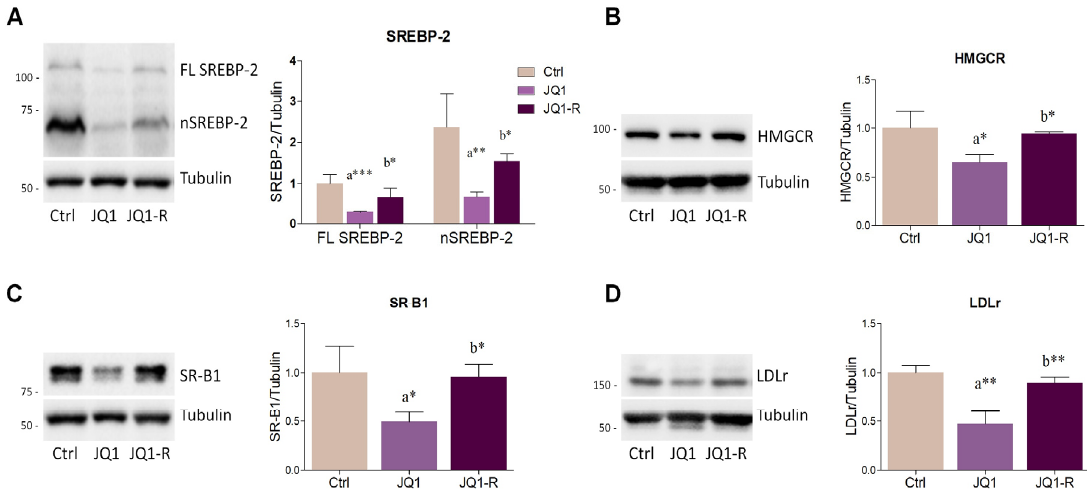
Figure 7. JQ1 resistance is accompanied by the upregulation of proteins controlling cholesterol metabolism. ( A–D ) Representative Western blots and densitometric analysis of SREBP-2, HMGCR, SR-B1and LDLr in JQ1-sensitive cells treated with vehicle (Ctrl) or JQ1 (0.4 µ M), and in HepG2-resistant (JQ1-R) cells constantly stimulated with JQ1 (0.4 µ M). Experiments were performed after 48 hours. n = 4 independent experiments. Tubulin served as loading control. Data represent means ± SD. Statistical analysis was assessed by using one-way ANOVA followed by Tukey’s post-hoc. * p < 0.05; ** p < 0.01; *** p < 0.001. “a” indicates statistical significance versus control group (Ctrl); “b” indicates statistical significance compared to JQ1 group.